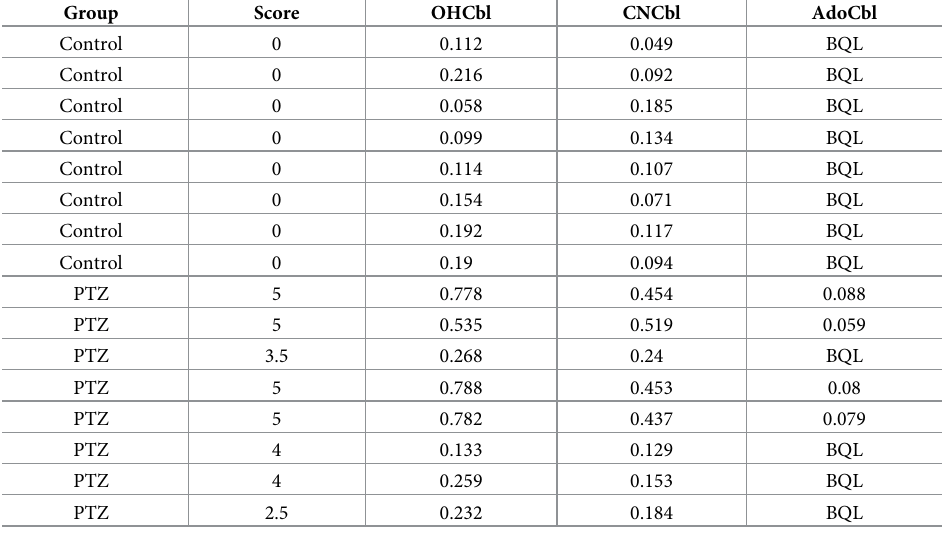
BQL: below the quantification limit.